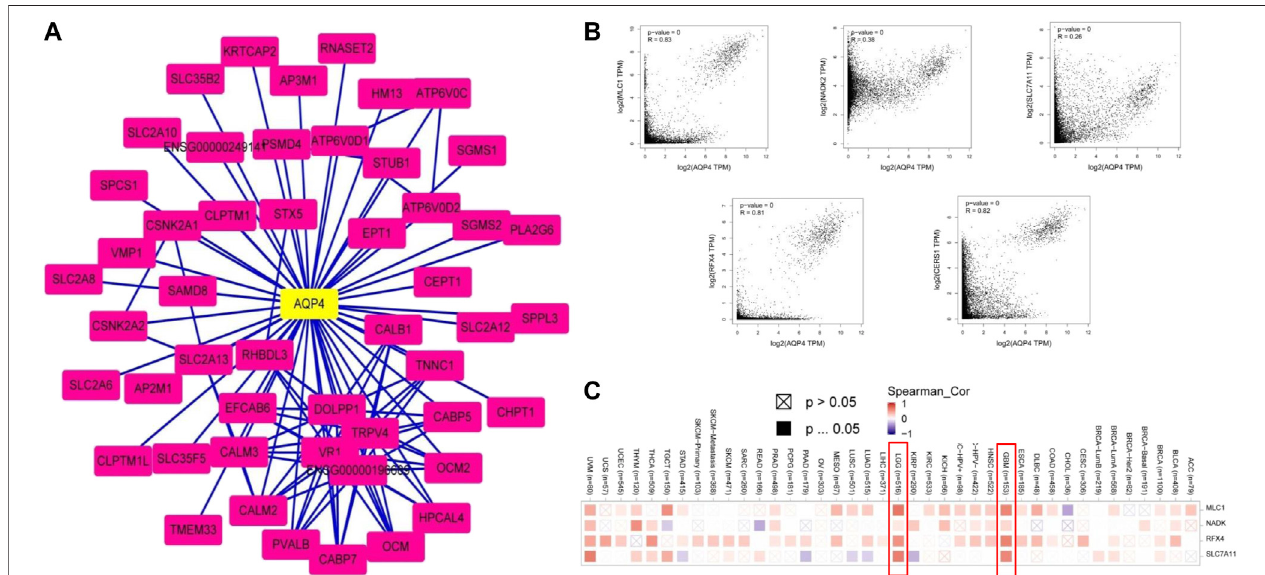
FIGURE 6 | AQP4-related gene enrichment analysis. (A) Firstly, protein candidates which bound to AQP4 were predicted using the STRING tool. (B) The GEPIA2 allowed us to determine the top 100 AQP4-correlated genes from the TCGA database. The correlation between AQP4 expression and selected targeting genes were analyzed, including MLC1, NADK2, SLC7A11, RFX4, and CERS1. (C) The corresponding heatmap data based on detailed cancer types are also shown.